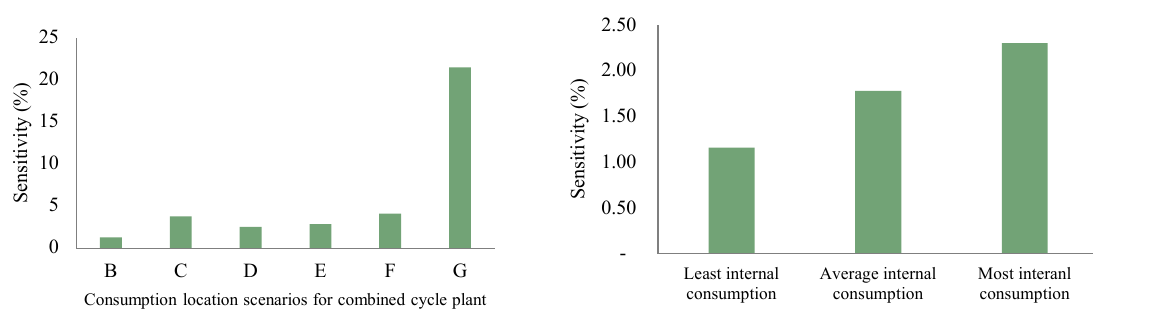
Fig. 7: Sensitivity of carbon footprint to group 2 scenarios for combined cycle Plant